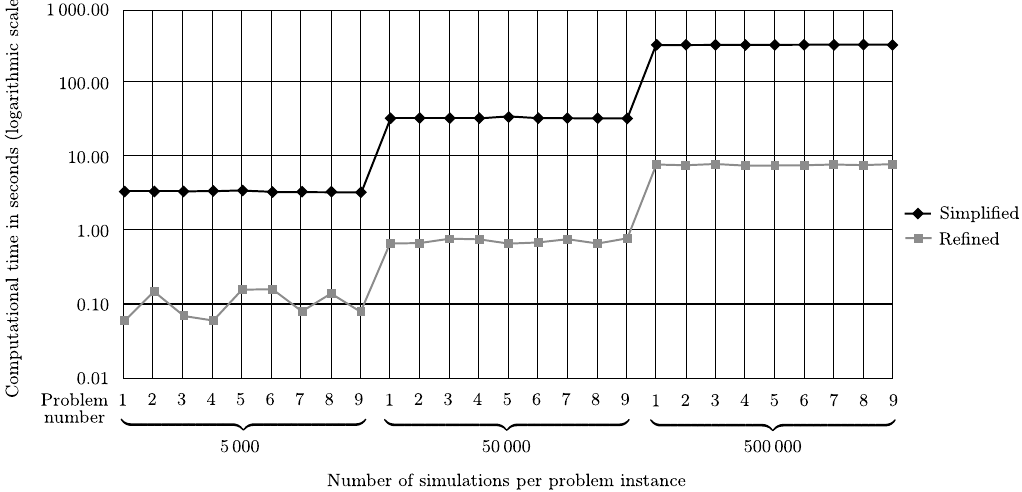
A graph of the computational times for the simplistic and refined MC methods for three different number of